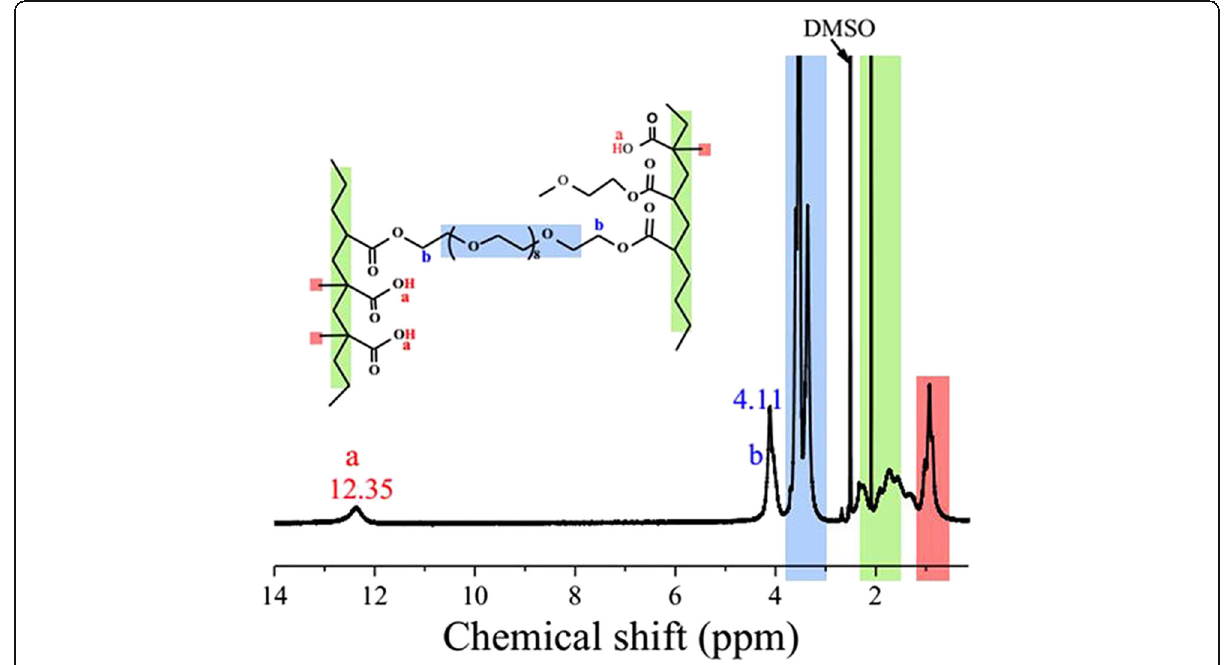
Fig. 1 1 H NMR spectrum of